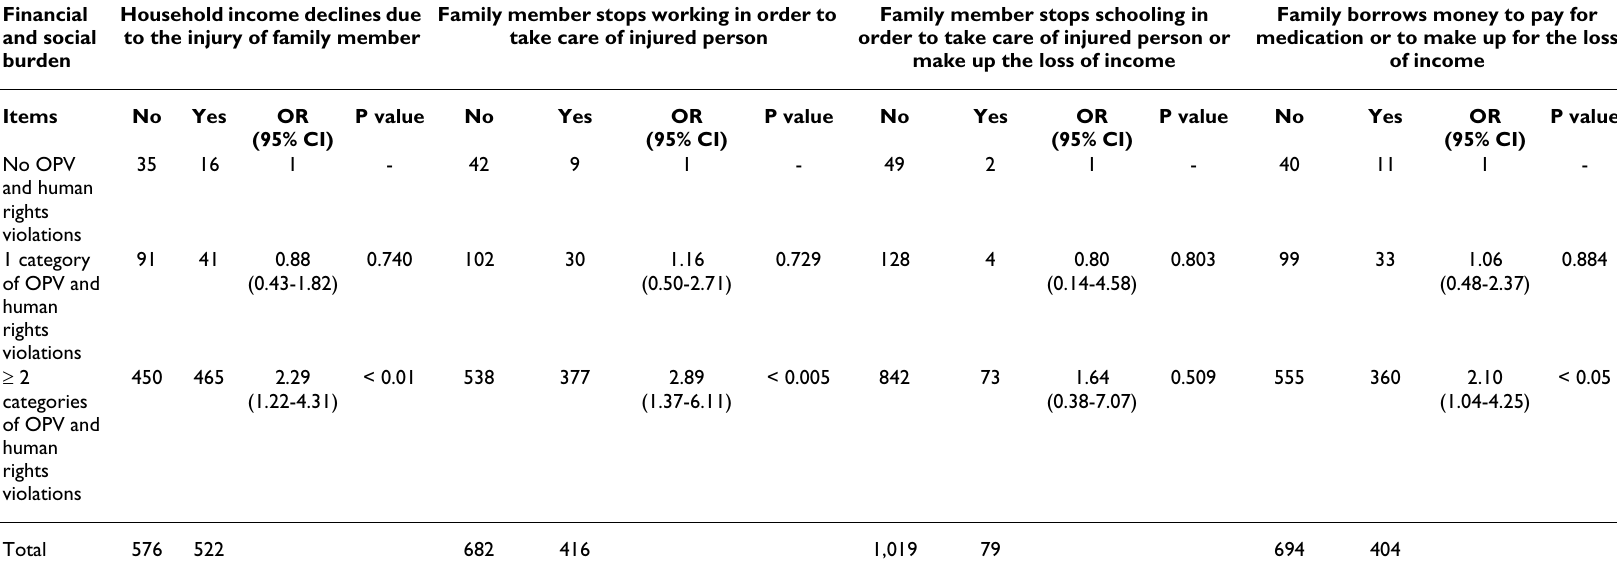
Table 5: Financial and social burden due to an injury event Financial and social